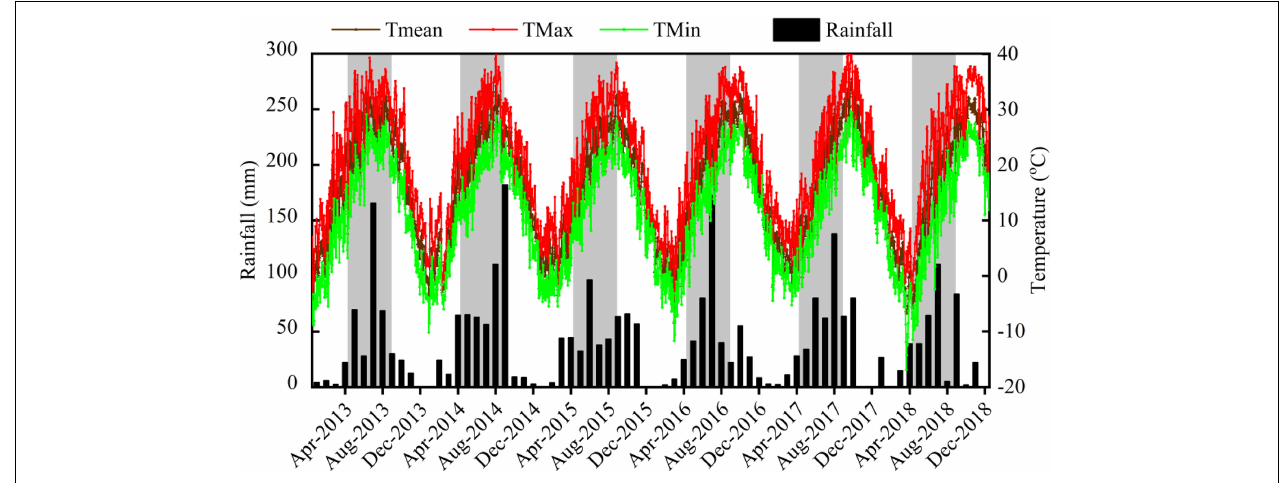
FIGURE 1 | Dynamics of temperature and rainfall during the experimental period. The gray areas represent the growing period of maize.